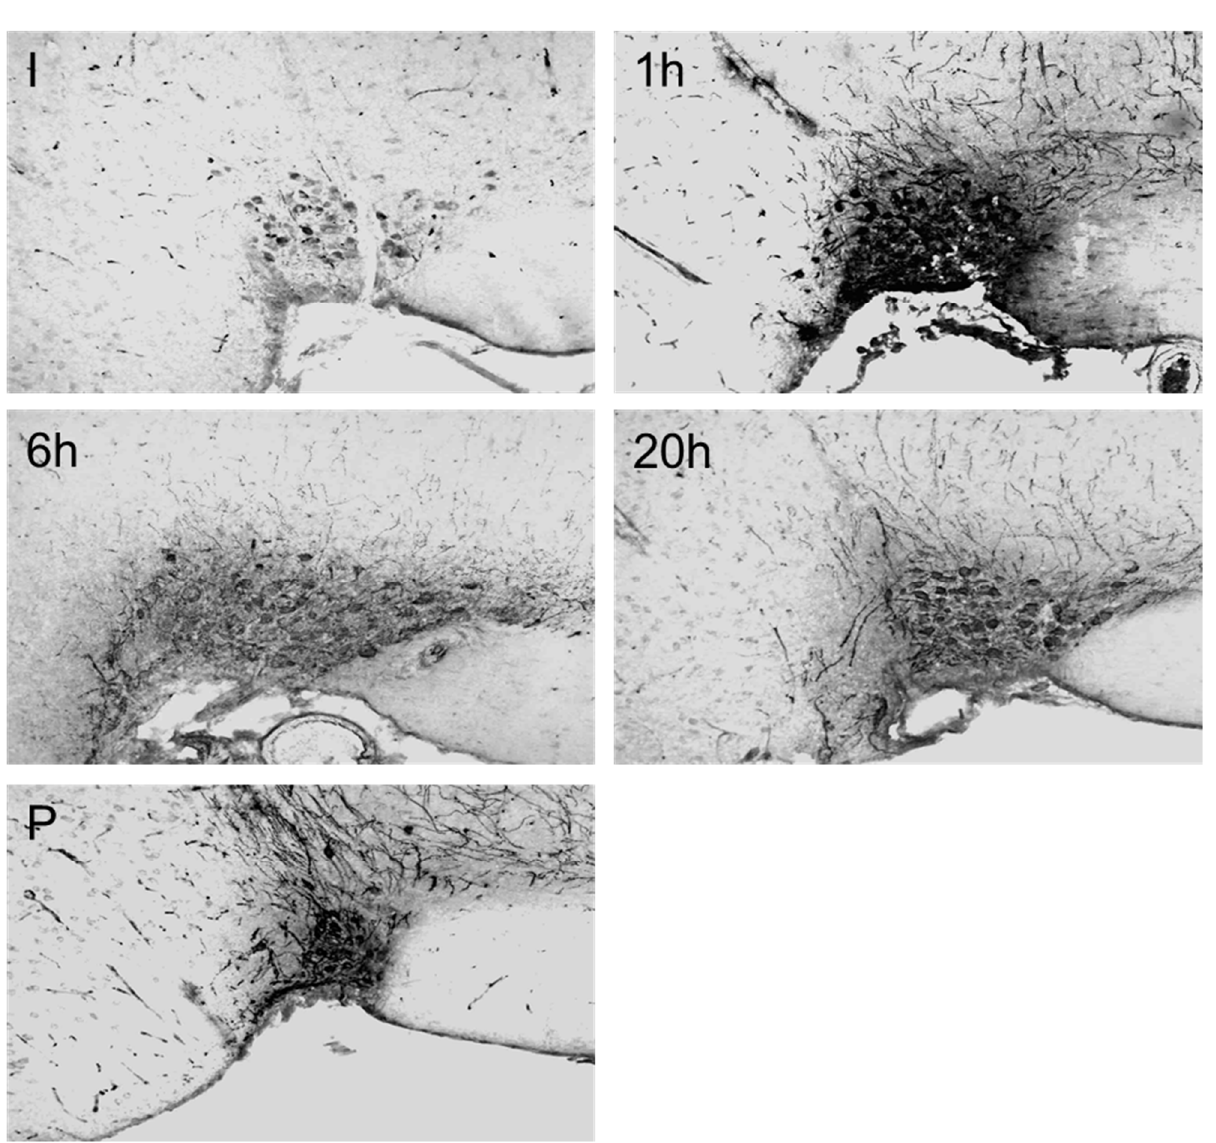
Figure A3. Arginine-vasopressin immunoreactivity in the supraoptic nucleus of Syrian hamsters. Comparison among immobilization stress (I, group 4), 1 h manual sleep deprivation (1 h, group 3a), 6 h manual sleep deprivation (6 h, group 3b), 20 h manual sleep deprivation (20 h, group 3c) and sexual stimulation with pheromone (P, group 2). Magnification: 50×.